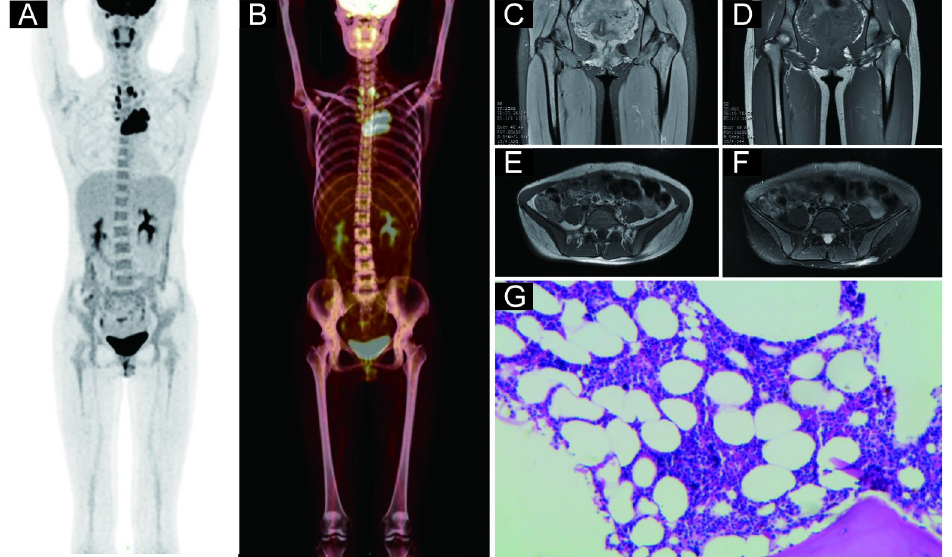
Fig 5. Representative case of a 30-year-old female diagnosed with diffuse large B-cell lymphoma. (A) and (B): Coronal positron emission tomography (PET) and PET-computed tomography images, respectively, revealing increased diffuse 18 F-fluorodeoxyglucose uptake (higher than that in the liver) in bone marrow throughout the patient’s body. (C)–(F): Pelvic magnetic resonance imaging revealing no abnormal signals on the T1-weighted or fat- suppressed T2-weighted images. (G): Hematoxylin and eosin staining confirmed that there was no bone marrow involvement in this patient. The patient’s blood glucose level before the PET/CT imaging was 4.1 mmol/L.